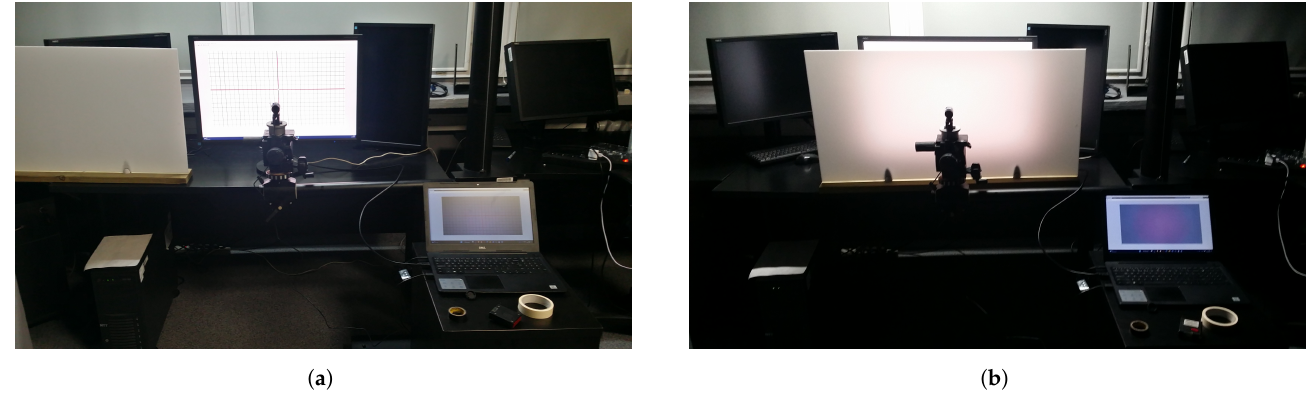
Figure 3. Laboratory setups used during: ( a ) positioning of camera; and ( b ) aquisition of the test images. The lighting in the laboratory was turned on only for taking the presented